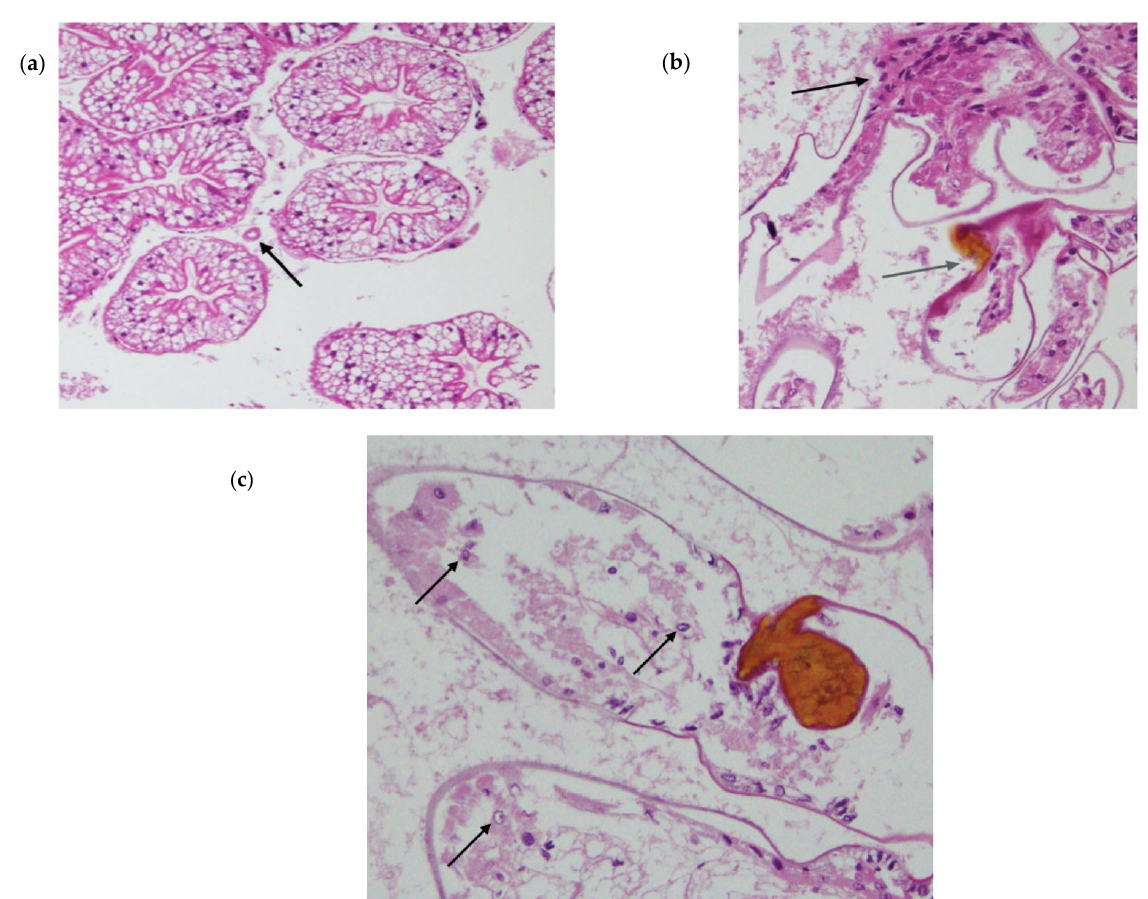
Figure 5. Histology of crayfish tissues. ( a ) granuloma-free haemolymph vessel in the hepatopancreatic tissue of infected crayfish. ( b ) black arrow: aggregation of nuclei (inflammation and tissue repair); grey arrow: necrosis and melanisation in infected crayfish. ( c ) signet ring cells in the secondary gill filament of infected crayfish. Note the large area of melanisation at the right of the photograph.